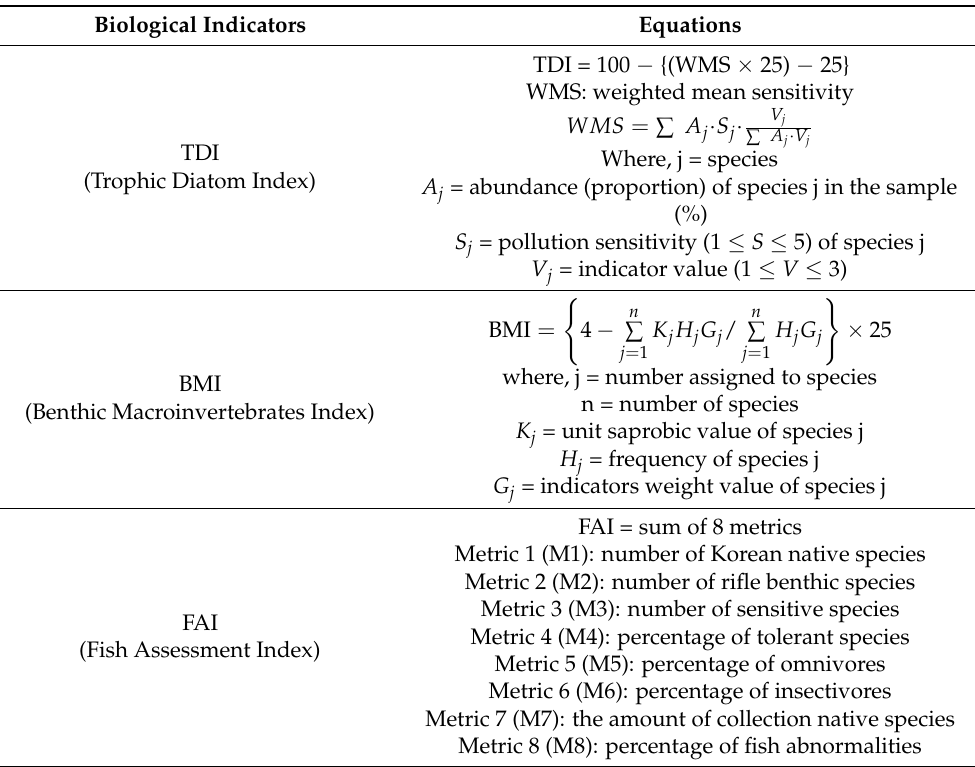
Table 1. Equations for computing the biological indicators developed by National Aquatic Ecological Monitoring Program